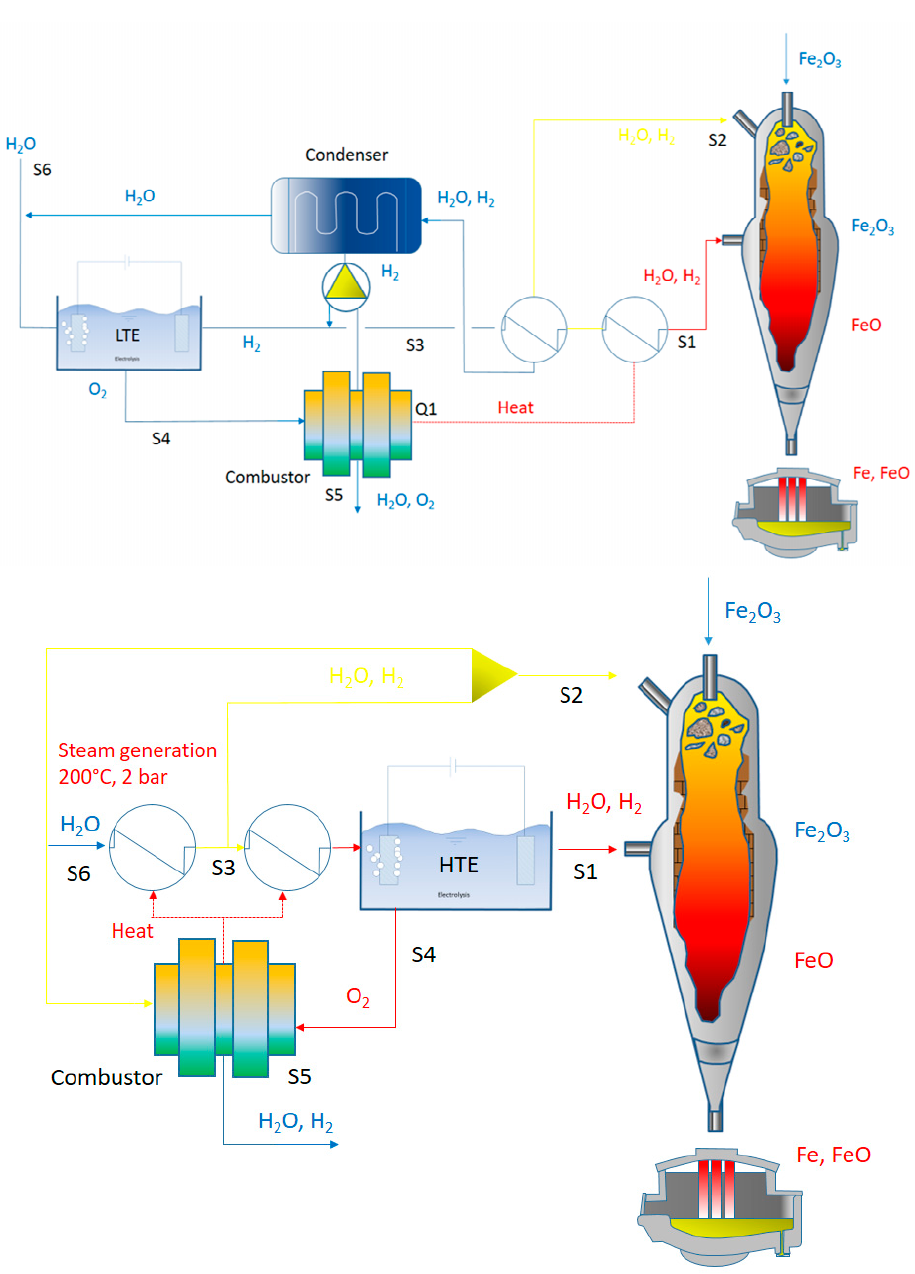
Figure 14. Schematic of the integration of DRI with LTE and HTE.